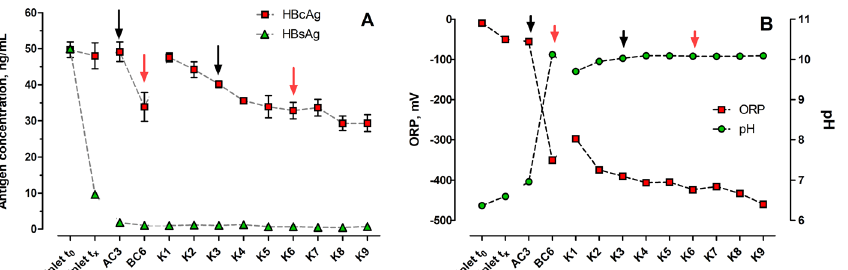
Figure 3. ( A ) Changes in core (HBcAg) and surface (HBsAg) antigen concentrations when treated in the MFC cascade. ( B ) Changes in redox potential and pH along MFC cascade setup. Red and black arrows indicate two corresponding MFCs in control open circuit cascade and closed circuit cascade. For clarity, only fluidically neighbouring points of the MFC setup have been connected by dashed lines. Data represent average ±